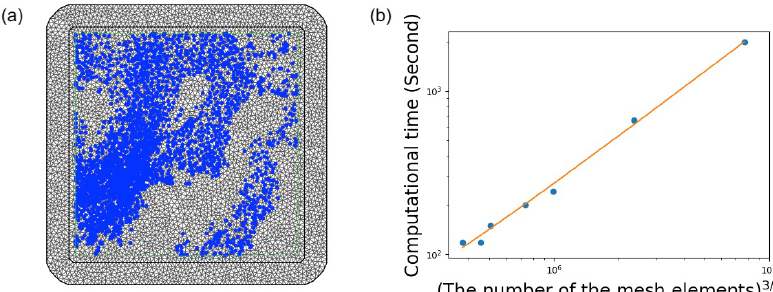
Figure 2. Panel (a) is the mesh elements and observed data, which is plotted with a blue marker, at 06:00:00UTC. The number of mesh elements is about 5200. Panel (b) is the relationship between computational time and the number of the mesh elements to the 32nd power. The computation time is the average value of the time at 05:46:30, 06:00:00, 06:08:00, and 06:16:00. The orange solid line is the regression line. The coefficient is 0.000259, and the intercept is 12.044.